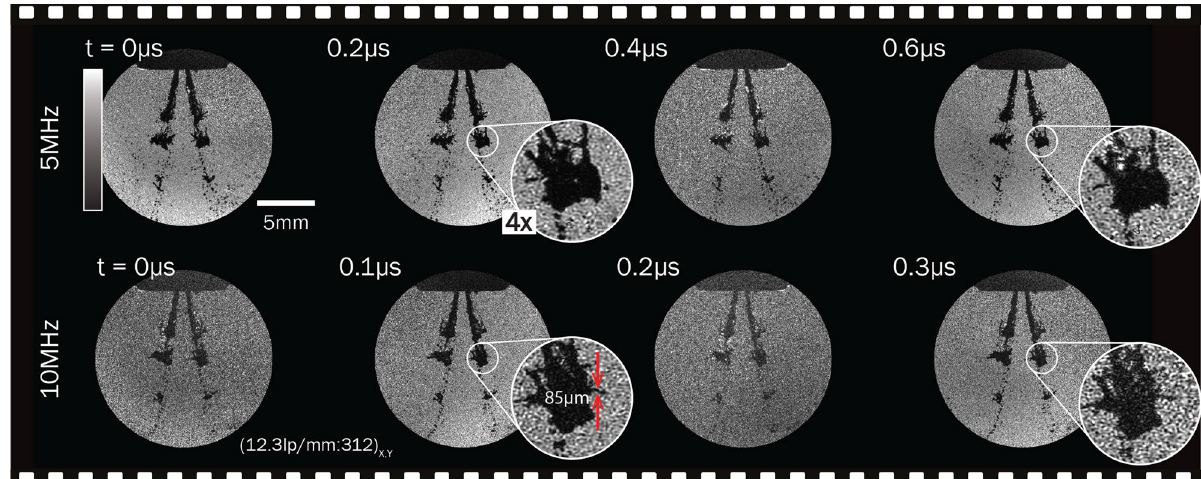
Figure 6. The preservation of FOV at high speeds. A set of image series of the injection event taken at speeds of 5 and 10 MHz, 2.3 ms ASOI. Fine structures are still equally visible for these higher speeds. Measurements on a Sector Star target show no degradation of the spatial resolution at these frame rates, i.e. (12.3 lp/mm:312) X , Y is